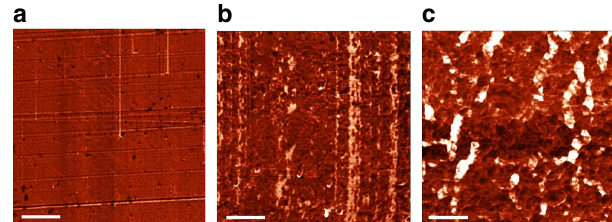
Fig. 2 Morphological investigations. Atomic force microscopy images of the mechanically adaptive polymer composites (phase mode). a Morphology of the original material. b , c After the free liquid crystal is washed away with acetonitrile, the polymer network is revealed. The morphology of the material differs between the top side b and on the bottom side of the thin fi lm c . Scale bars are 1 μ